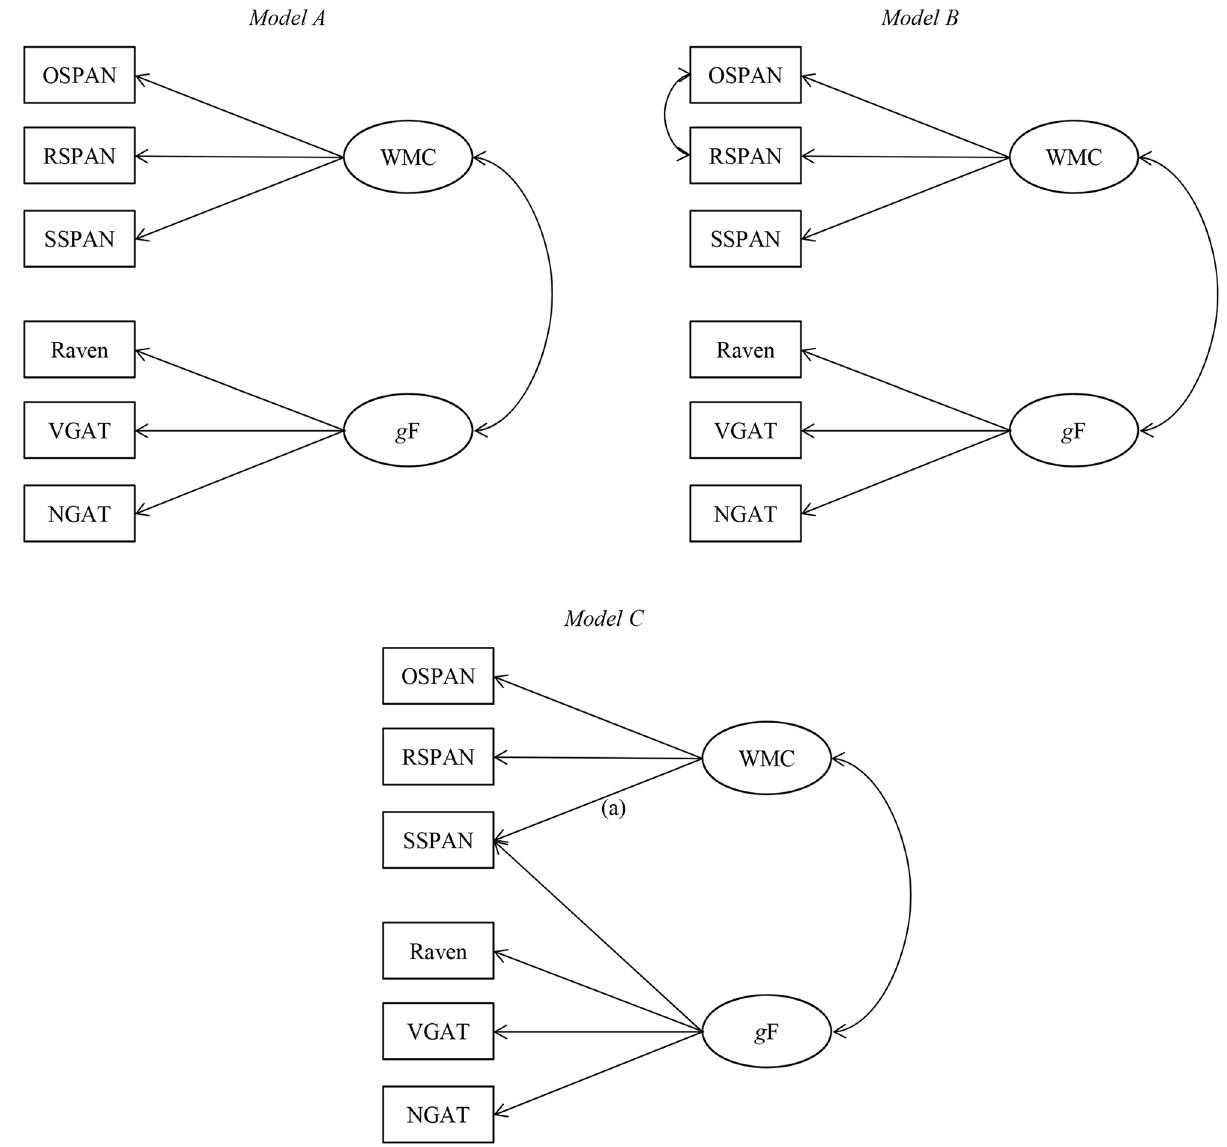
Fig 3. Schematic presentation of path models for the structural equation analysis of the relation between working memory capacity (WMC) and fluid intelligence ( g F). Each model was tested for each type of WMC score and in subsamples with and without the 85% accuracy criterion on the processing component of span tasks. The paths leading from the constructs (circles) to the manifest variables (rectangles) represent the loadings of each measure on that construct. The double-headed paths between the WMC factor and the g F factor represent the correlation between the two constructs. The double-headed path between the OSPAN and RSPAN manifest variables in Model B represents the correlation between the residuals of these two measures. By exclusion of path (a) in Model C it was possible to test an additional model in which SSPAN is related only to the g F latent factor, but not with WMC factor. All paths and loadings in all models are significant at the p < .001 confidence level, for each type of WMC scores and in all analysed subsamples. OSPAN = operation span; RSPAN = reading span; SSPAN = symmetry span; Raven = Raven Advanced Progressive Matrices; VGAT = Verbal General Ability Test; NGAT = Numerical General Ability